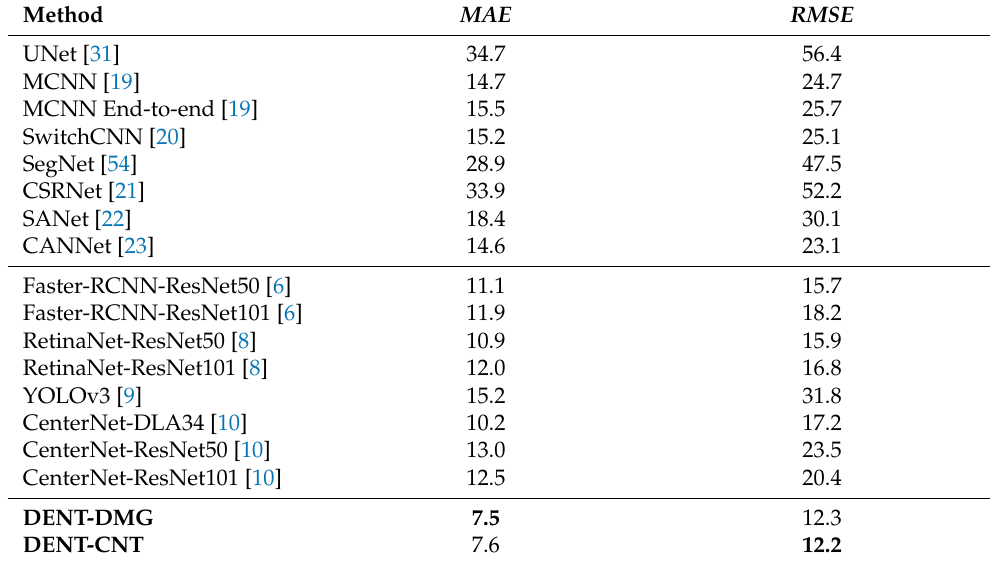
Table 2. Counting errors of different approaches on NeonTreeEvaluation Dataset. The bold numbers are the lowest values in each